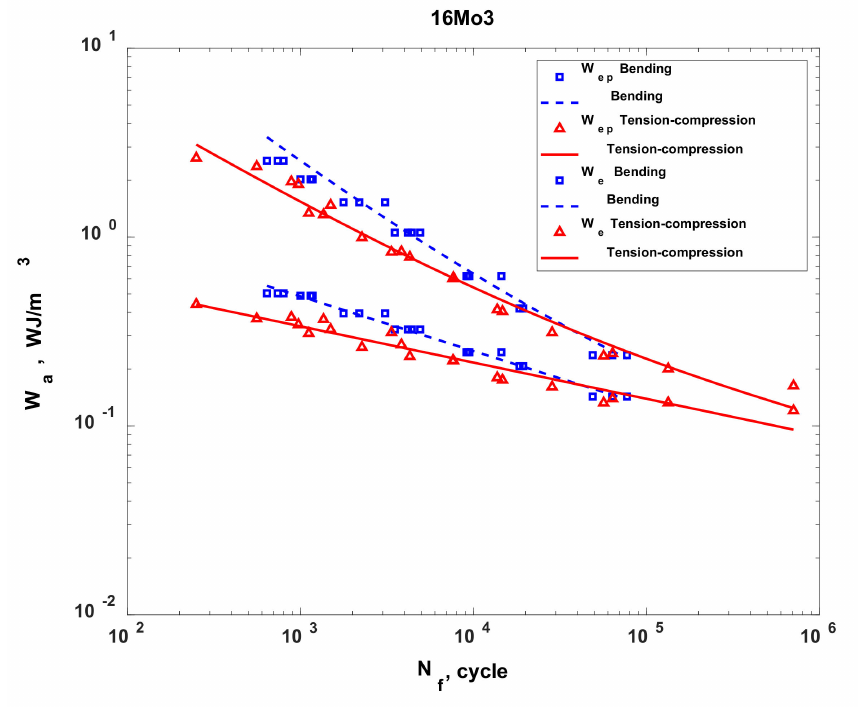
Figure 8. The energy characteristic for the 16Mo3 steel, developed for the cases of tension-compression and oscillatory bending.